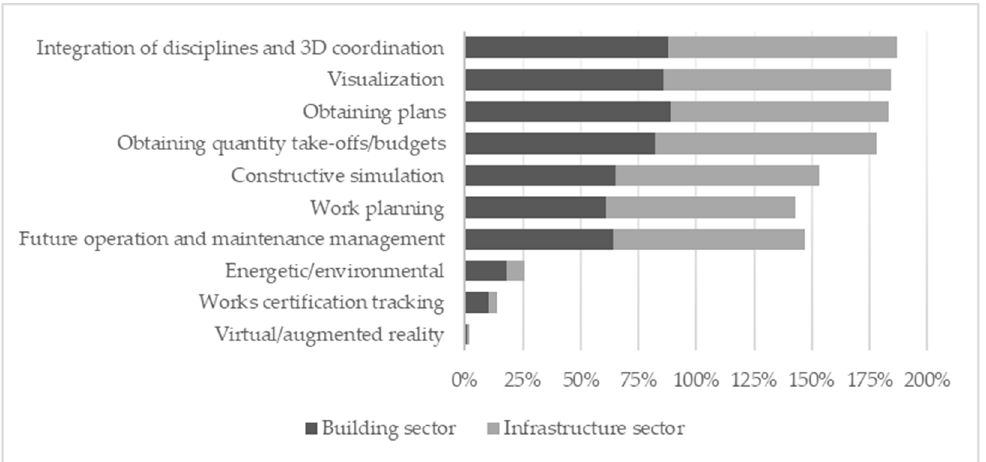
Figure 5. Inclusion of BIM uses in contracts by sectors. Source: Own elaboration based on [33].